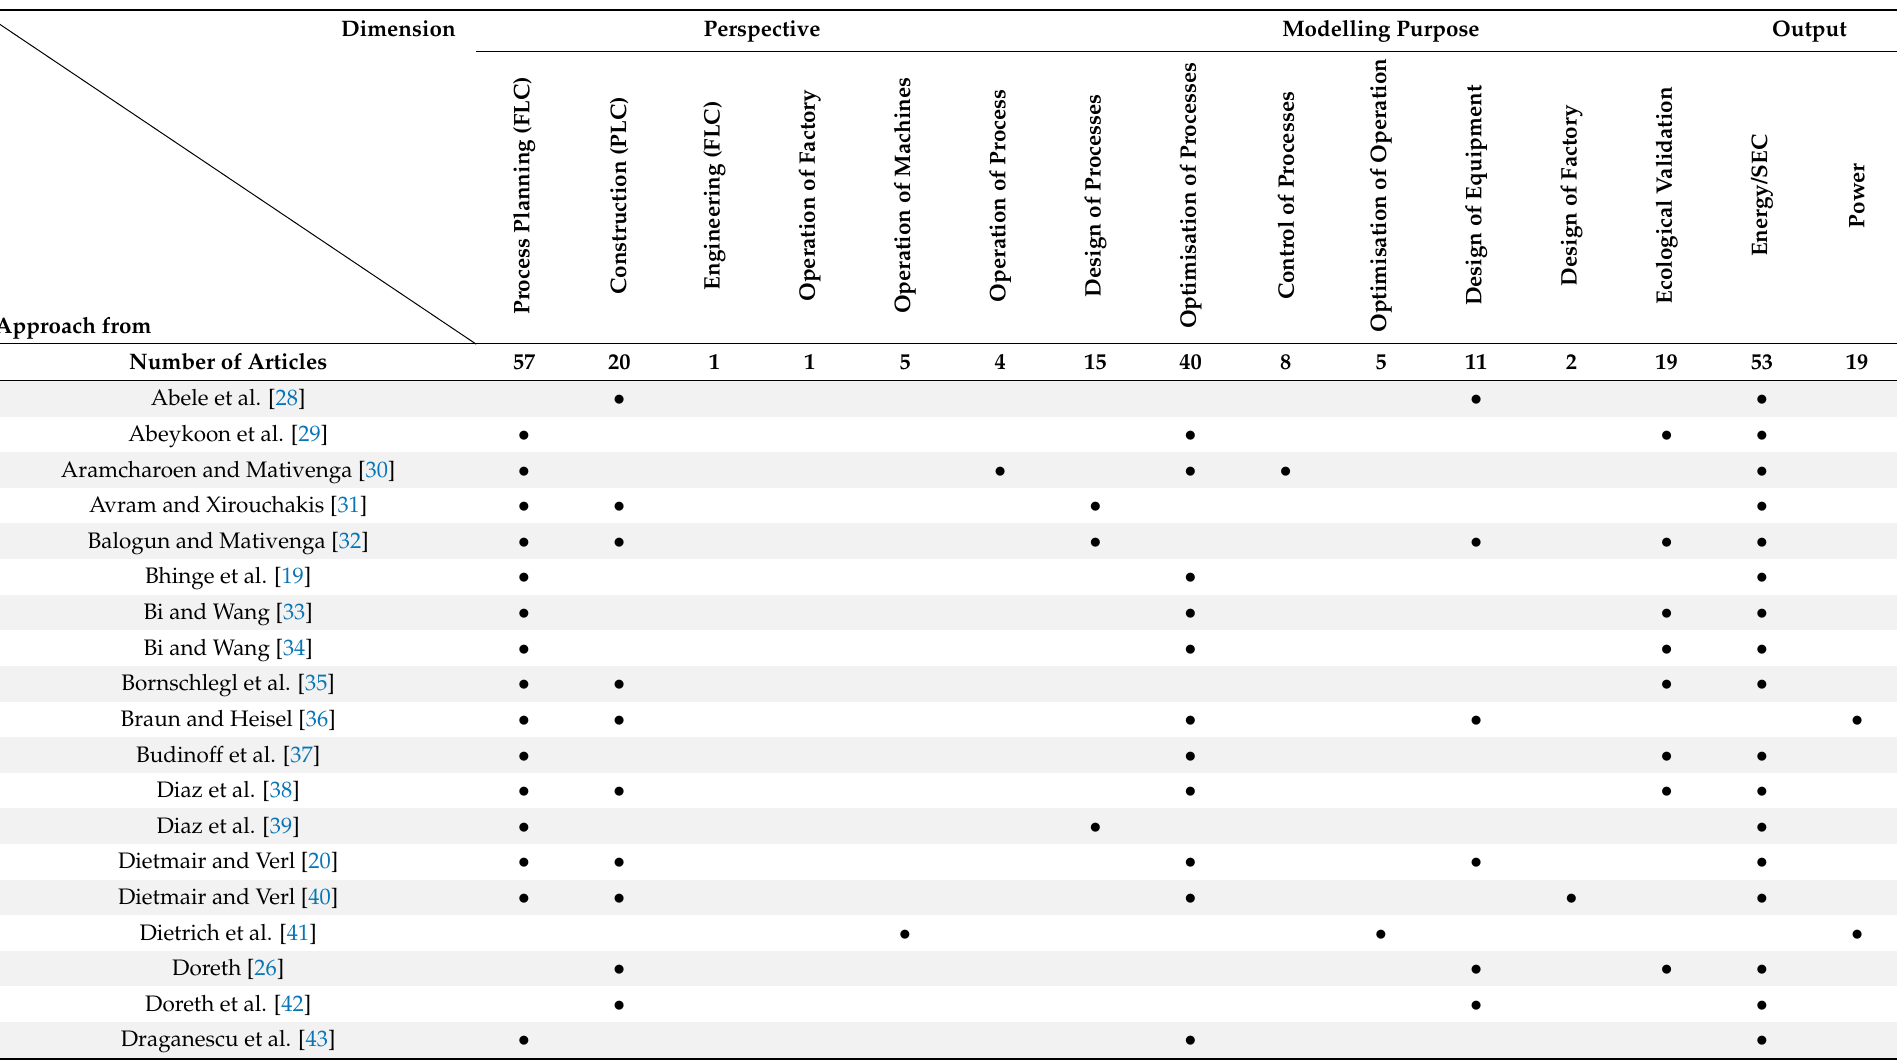
Table 3. Classification for Dimensions Perspective, Purpose of Modelling, and